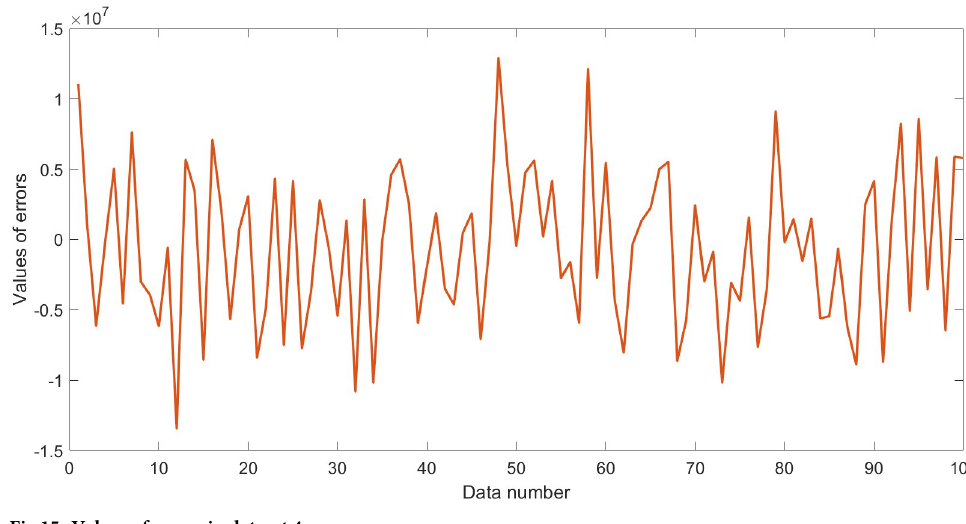
Fig 15. Values of errors in dataset